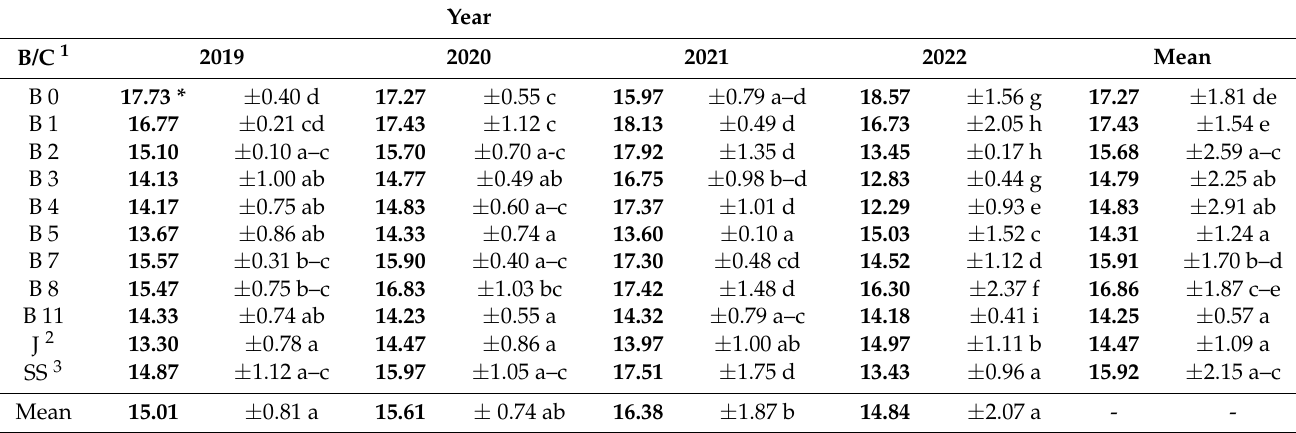
Table 11. TSS extracts (%) in fruits of tested biotypes and cultivars of Elaeagnus multiflora